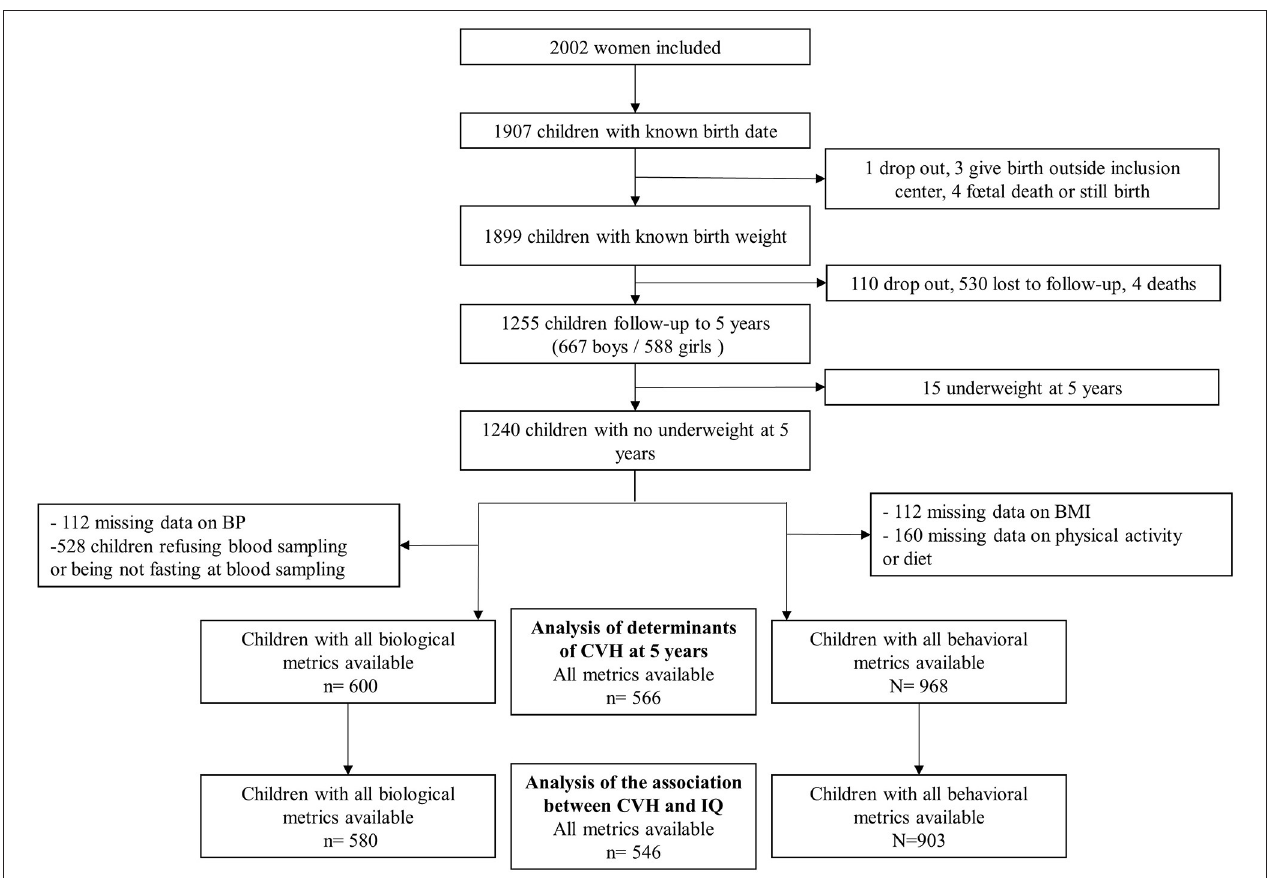
FIGURE 1 | Study flowchart. CVH, cardiovascular health; IQ, intelligence